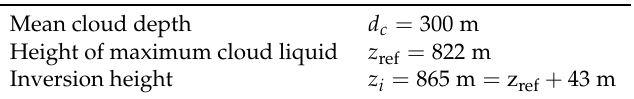
Table 1. Cloud geometry reference